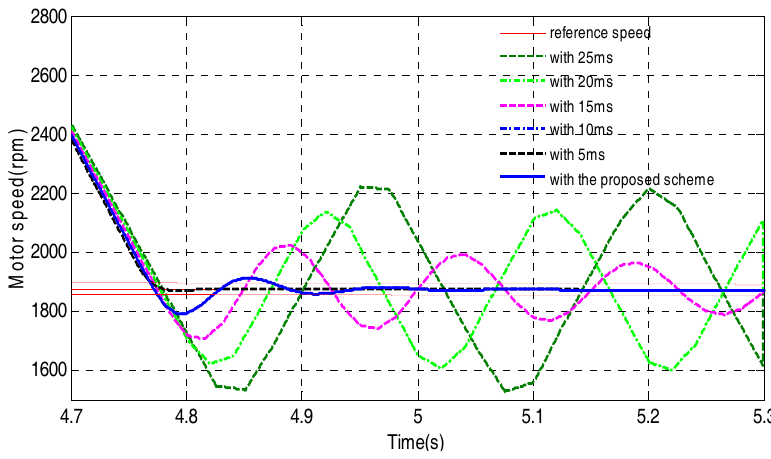
Figure 12. The upshifting process with different periods in the HIL tests. Energies 2017 , 10 , 1831